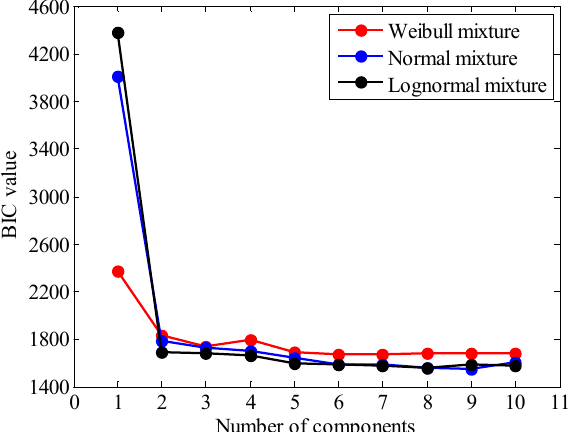
Figure 10. BIC values of mixture distribution of stress range.